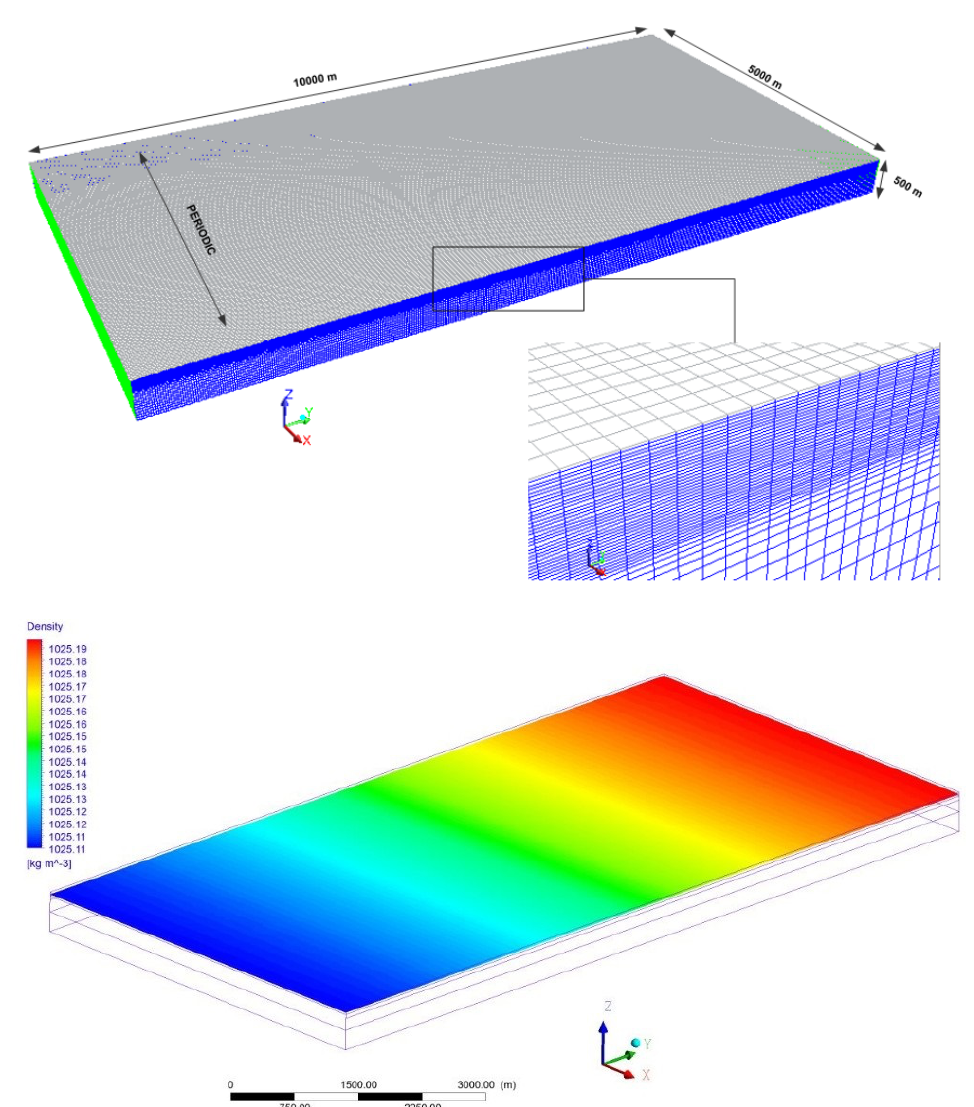
Figure 1. The computational model. The grid and dimensions ( top ) and the initial density distribution ( bottom